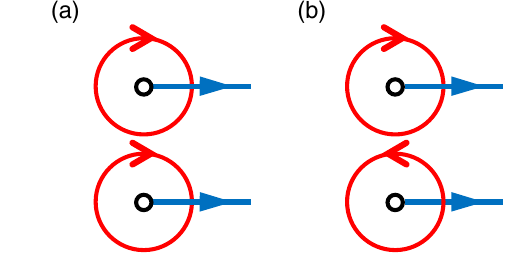
FIG. 2. The two-hole ground state Ansatz . (a) Two holes are composed of the same chirality of spin current in j Ψ holes are composed of the opposite chiralities of spin current in . See the definitions in j Ψ − i 2 h